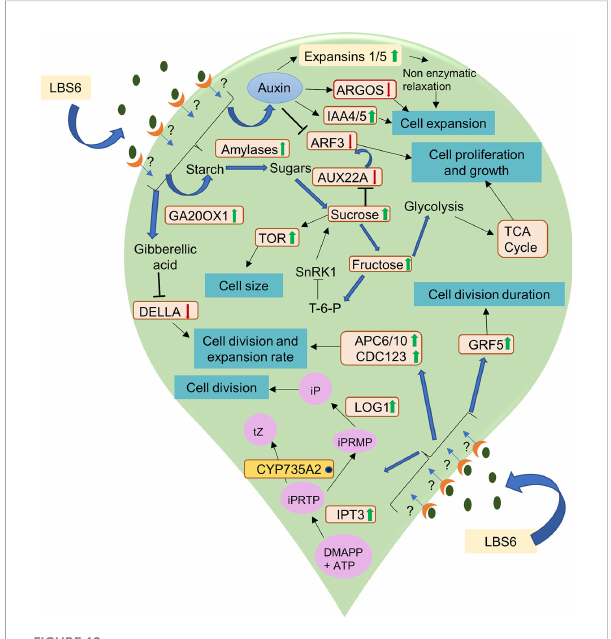
FIGURE 12 A schematic representation of the mode of action of LBS6 in stimulating cell division, expansion, proliferation in cucumber cotyledons. The green arrow shows the up regulation of the gene expression and enzyme activity, whereas the red arrow shows the downregulation. The blue dot represents no signi fi cant change in the expression. Abbreviations listed in the diagram are as follows: Ga20OX1 (gibberellin 20-oxidase 1), ARGOS (auxin regulated gene involved in organ size), IAA (indole acetic A inducible gene), TOR (target of rapamycin), ARF 3(auxin response factors 3), Aux22A (auxin induced protein 22A), APC6 (anaphase promoting complex 6), APC10 (anaphase promoting complex 10), CDC123 (cell division cycle protein 123 homolog), LOG1 (Lonely guy 1), GRF5 (growth regulating factor 5), DMAPP (dimethylallyl diphosphate), iPRTP (N6 -(2-isopentenyl D ) adenine riboside 5 ′ -triphosphate), iPRMP (N 6 -(2- isopentenyl D ) adenine riboside 5 ′ -monophosphate), iP (N6 -(D2 -isopentenyl)adenine), tZ ( trans